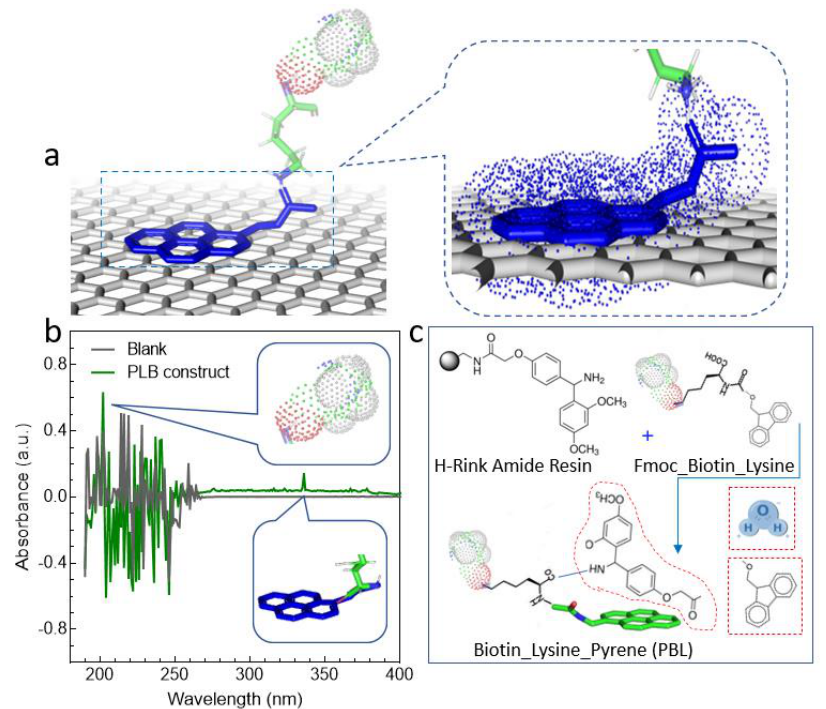
Figure 1. A schematic demonstration of functionalizing graphene with our engineered pyrene-based construct. ( a ) Pyrene interacts with graphene rings by sharing its free electrons. ( b ) The syn- thesized PLB construct was tested (via middle/long-wave UV spectra) for the successful conjugation of pyrene and the presence of biotin. Sharp clear peaks at 202 nm and 335 nm confirm the presence of biotin and pyrene. ( c ) The reaction mechanism for our engineered PLB construct. The synthesis reaction constitutes a series of deprotection and coupling steps. The Fmoc was removed via depro- tection using piperidine while coupling was assisted by coupling solution containing DIC and Ox- yma. 2. Material and Methods 2.1. The Growth of High-Quality Pristine Graphene (PG) Usually, substrates are functionalized using various two-dimensional (2D) materials [16 – 19], and their properties, which reflect various binding events, are monitored. In this regard, a 2D sp2-bonded carbon allotrope, graphene, has attracted enormous interest over the past decade due to its unique properties, such as ultrahigh electron mobility, uniform broadband optical absorption, and high tensile strength. Hence, monolayer, large-size, and high-quality pristine graphene was grown via the chemical vapor deposition (CVD) method. This method was selected since CVD-derived graphene is polycrystalline and good-quality [20 – 23]. The copper-foil nook was shaped by twisting a 25 mm thick copper foil (Nilaco Corporation, Tokyo, Nilaco Bldg.,Japan) and afterward creasing the three left- over sides. Methane flow was kept at 1 sccm at 50 mTorr, and the temperature remained at 1035 °C followed by the 2.0 h ramping process. At temperatures above 1035 °C, large- domain graphene growth was observed on the copper-foil enclosure. The procedure is described in agreement with the literature [24 – 28]. Graphene grew on both the inside and outside of the Cu enclosure. The back-end graphene was etched via oxygen plasma etching. The graphene was coated with PMMA using a spin coater at 4000 PRM for 1 min. After transferring, the Si/SiO 2 substrate was dried in an oven at 80 °C for 1 h Finally, the substrate was dried by a nitrogen blow fol- lowed by washing using acetone for PMMA removal and methanol for acetone removal. The graphene layer was transferred to our working substrate (Si/SiO 2 ) via the wet transfer